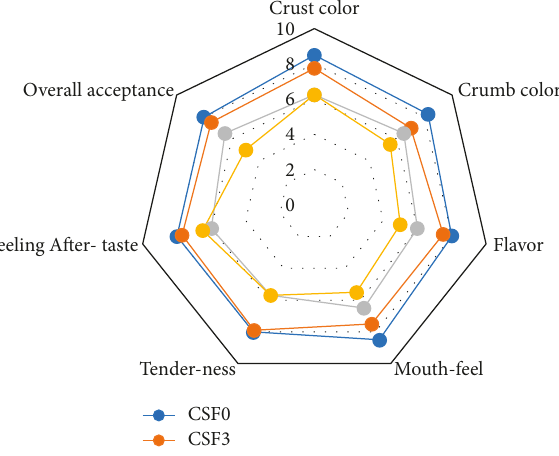
Figure 2: Sensory profile of cake with chia seed Table 7: Total phenolic content (TPC) and antioxidant activity of cake.